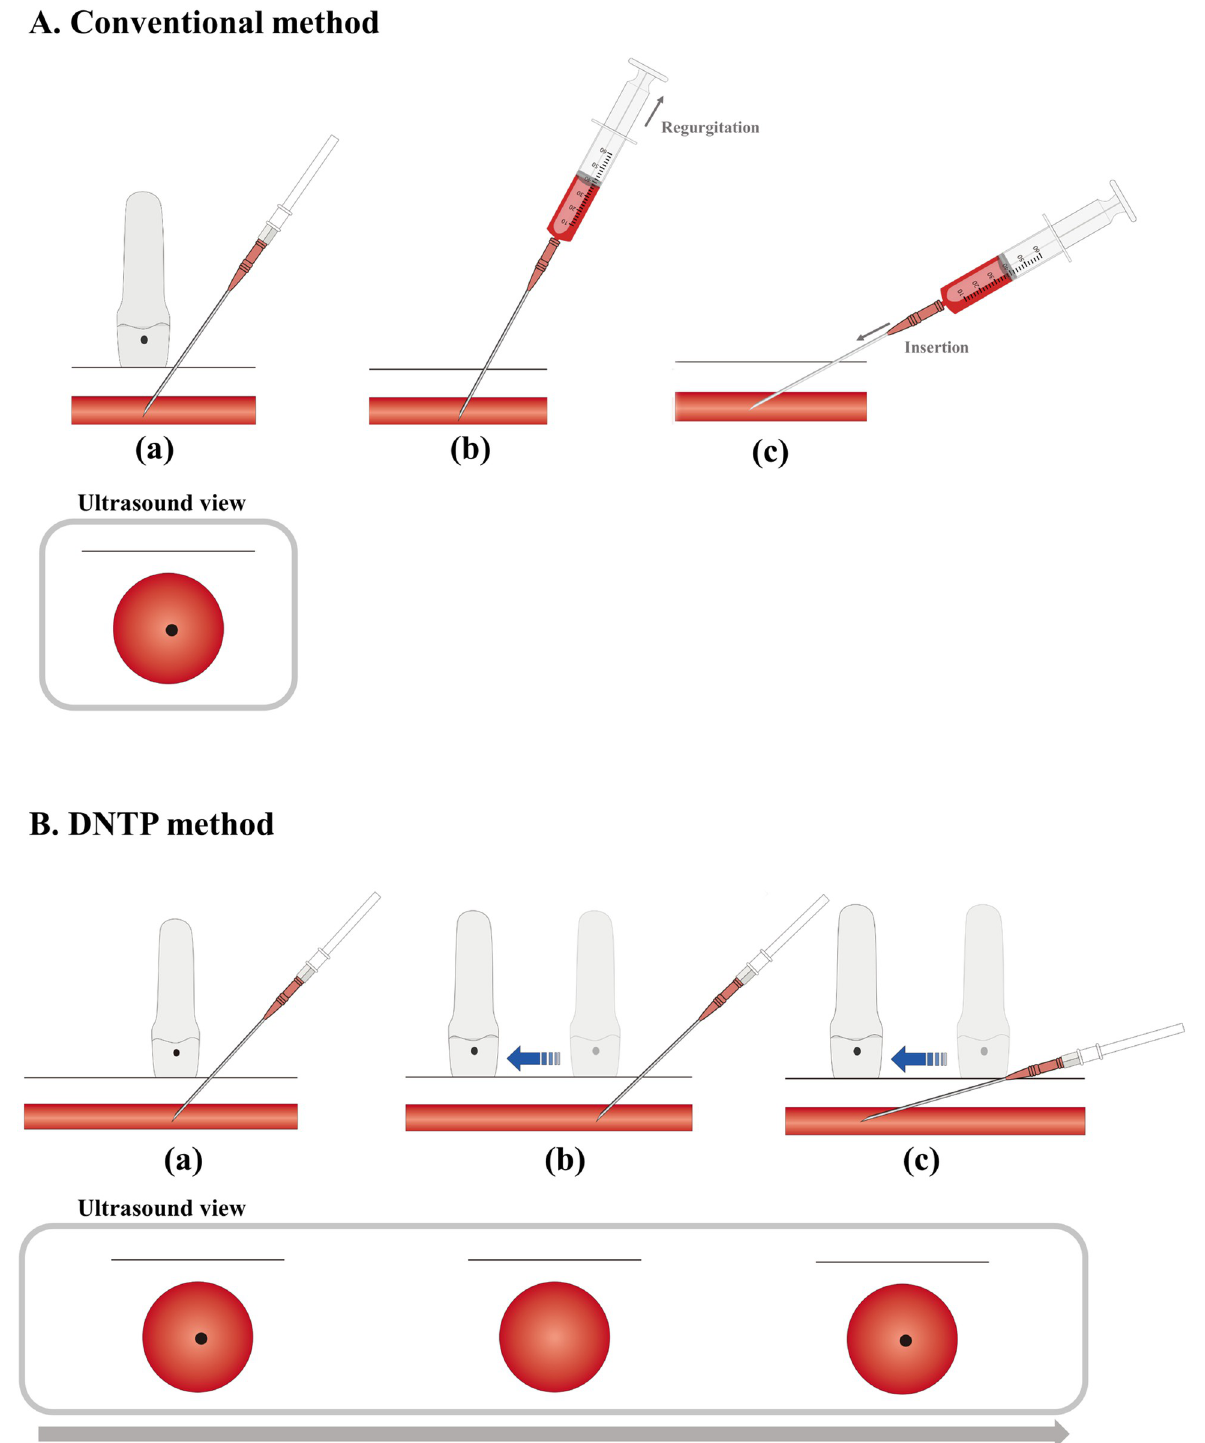
Fig 1. Illustrations for two ultrasound-guided radial artery cannulation methods. A. Conventional method (a) Confirmation of needle tip visualization in the centre of intra-arterial lumen on the ultrasound screen. After confirming that blood has been aspirated into the catheter hub, the needle is advanced slightly whilst reducing the puncture angle, and an external catheter was inserted into the artery. Then, after the inner guide needle is removed, the (b)and (c) process are performed sequentially if the blood return is not observed. (b) The outer catheter was withdrawn by applying negative pressure until the blood aspiration is observed again, (c)If blood aspiration continued, an outer- catheter is inserted into the